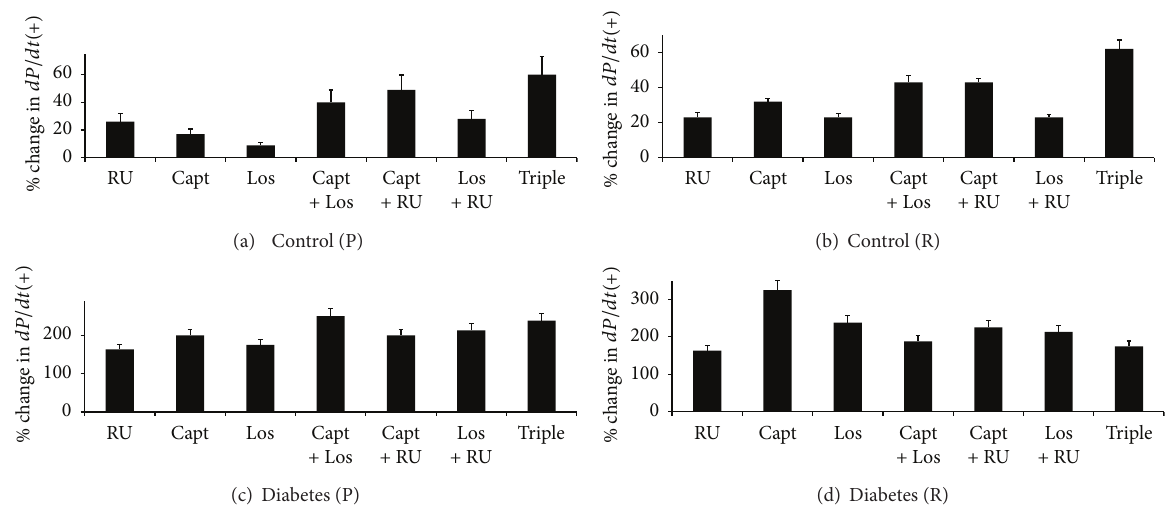
Figure 7: A comparison of the % change in positive derivative of pressure ( +𝑑𝑃/𝑑𝑡 ) in control and diabetic hearts following acute treatment with various drug regimens. Drugs were given to control hearts during perfusion (a) or reperfusion (b) and to diabetic hearts during perfusion (c) or reperfusion (d). The percent change in parameter is calculated relative to the % recovery seen in the respective nondiabetic or diabetic controls. RU: RU28318; Capt: Captopril; Los: Losartan; Triple: RU28318 + Captopril + Losartan.